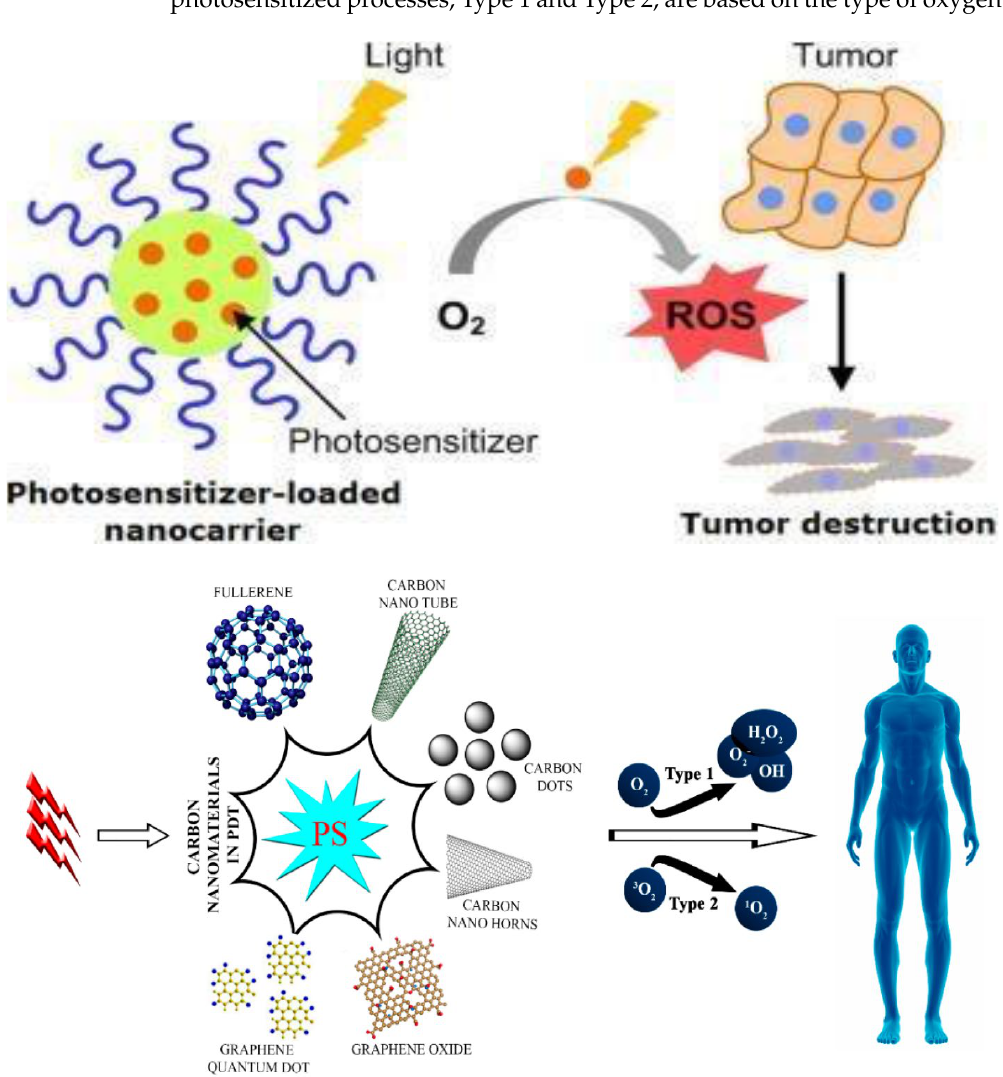
Figure 13. Schematic illustration of the theranostic of disease photo-triggered by carbon-based CNMs, which are targeted and effective in PDT for cancer [223]. Copyright 2016, MDPI, Open Access.